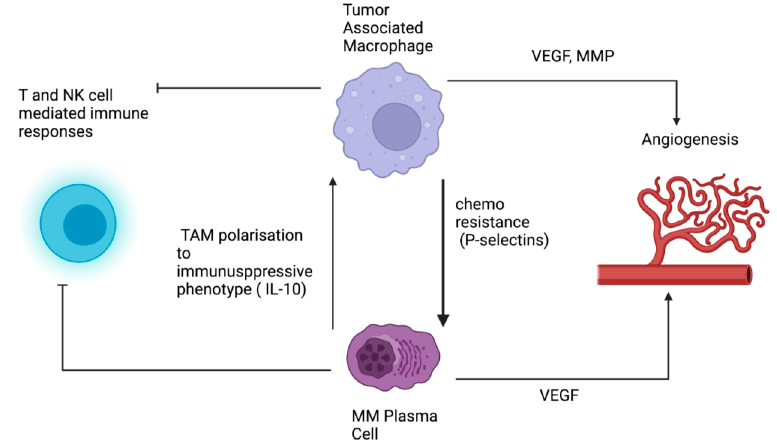
Figure 1. The interaction between multiple myeloma (MM) plasma cells and tumor-associated macrophages (TAM). Plasma cells promote polarization of TAMs towards an immunosuppressive phenotype, while TAMs confer chemoresistance properties to MM cells via P-selectins. Both TAMs and MM cells promote angiogenesis and suppress T-cell- and NK-cell-mediated anti-tumor immunity. NK = NK cell, VEGF = vascular endothelial growth factor, IL-10 = interleukin 10, MMP = matrix metalloprotease.